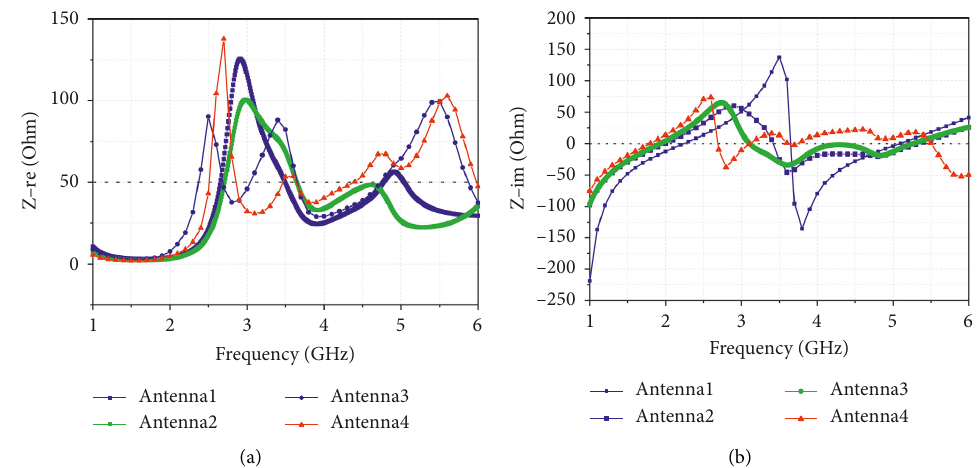
Figure 9: Input impedance comparison of four antennas. (a) Real parts of input impedance of antenna 1, 2, 3, and 4. (b) Imaginary parts of input impedance of antenna 1, 2, 3, and 4.